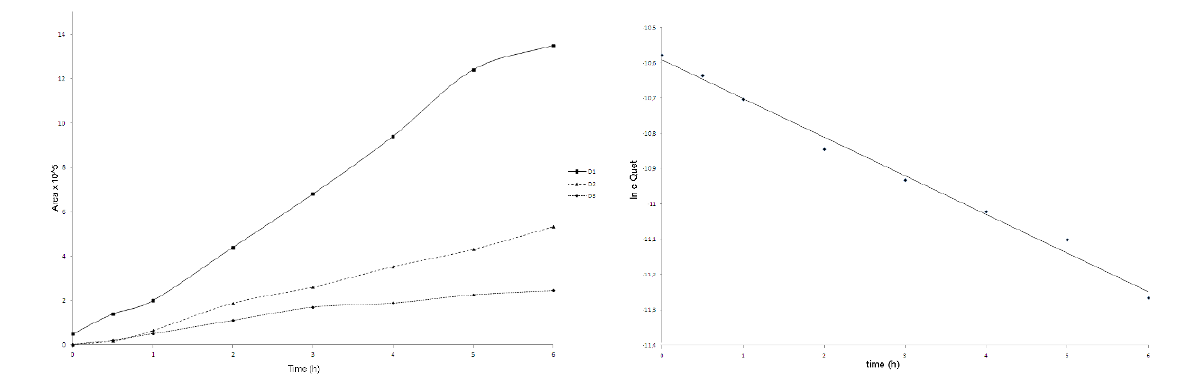
Figure 8. Evaluation profile of the main photodegradation products (D1 – D3).